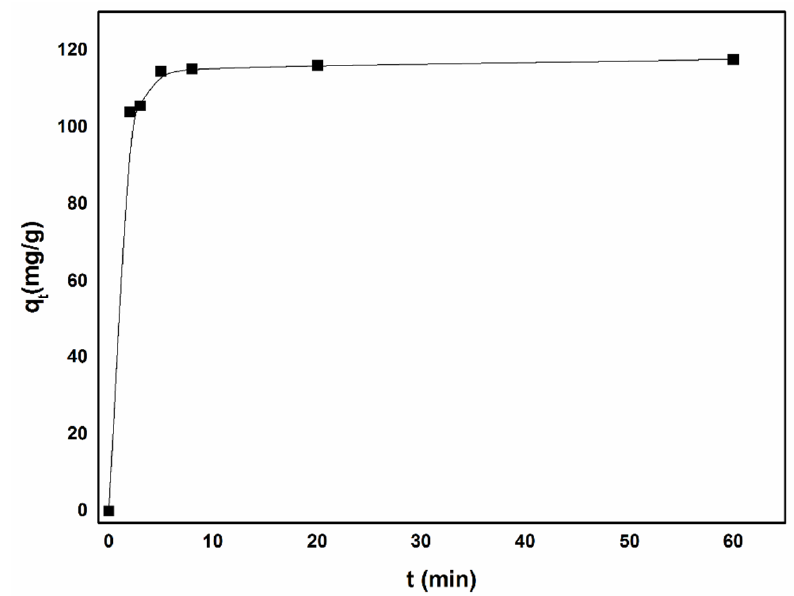
Figure 11. The Cr(VI) adsorption kinetics of Fe/CA.